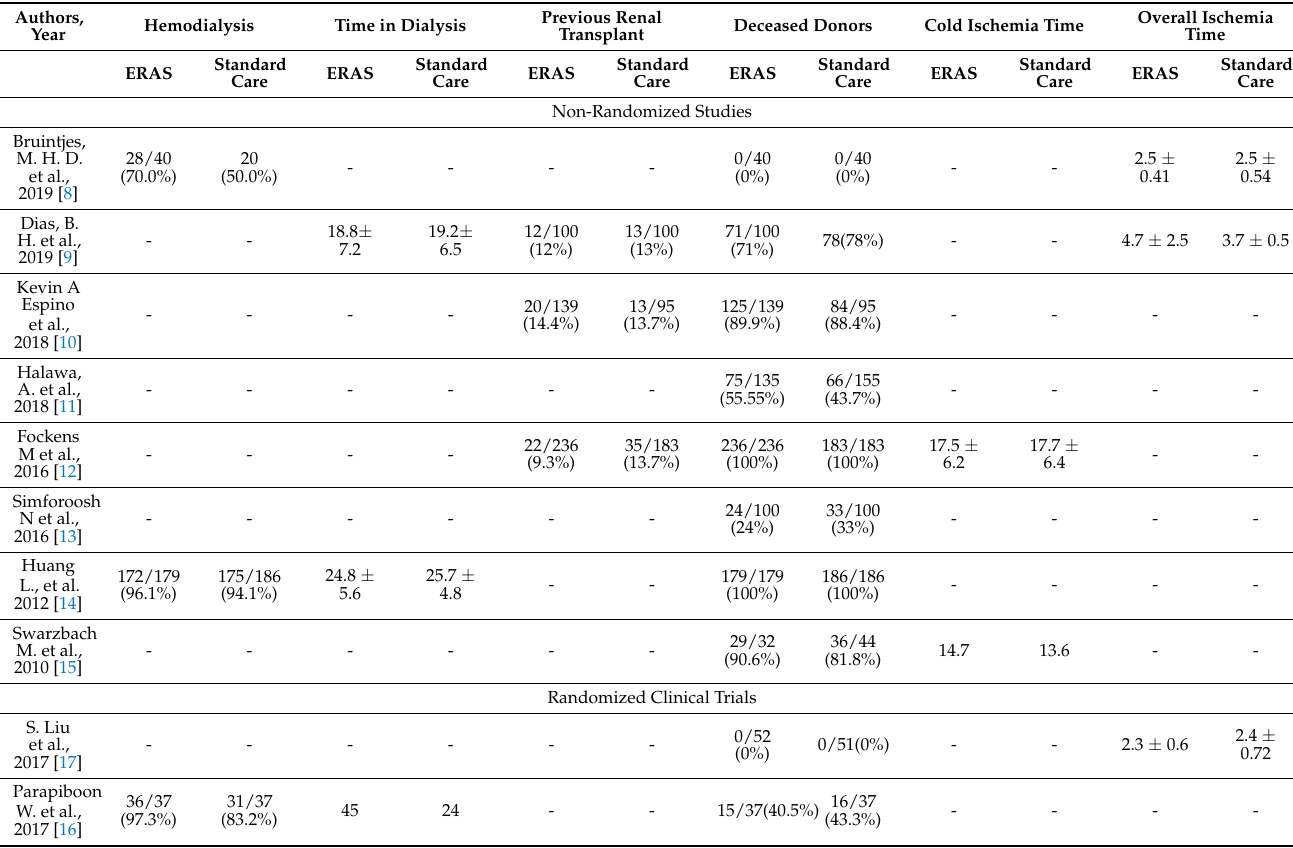
Table 4. Recipients’ background (B).